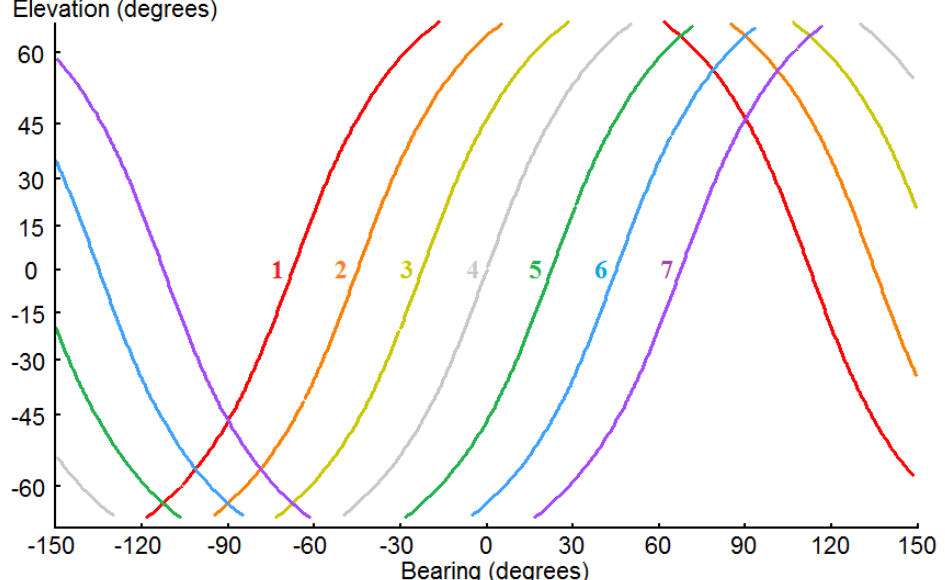
Figure 4. Skeletonised synthetic-aperture image of the field of audition in a Mercator projection. Lambda circles are shown for seven discrete bearings, in which the head faces as it turns (or yaws) from 67.5° to the left (port) (index 1; coloured red), through 22.5° increments, to 67.5° to the right (starboard) (index 7; coloured violet) with respect to the mean position (0°, index 4; coloured grey). For all of the lambda circles, the auditory axis has imposed on it a constant lateral tilt (or roll) of 20° downslope to the right across the head.